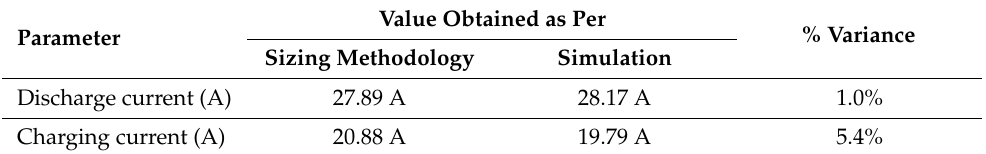
Table 8. Capacitor charging and discharging currents of a compensating module for 7.5 kw induction